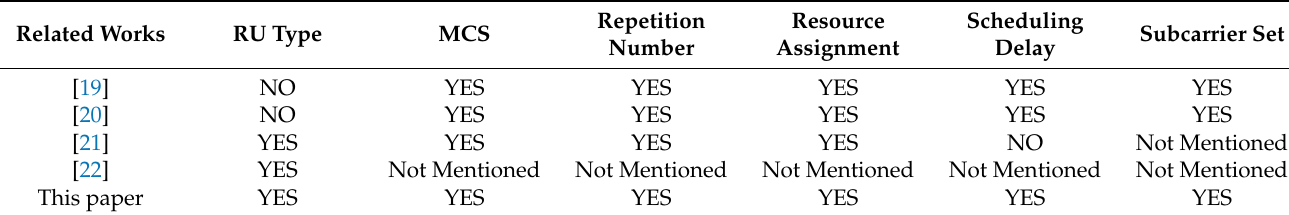
Table 1. Supported scheduling parameters.